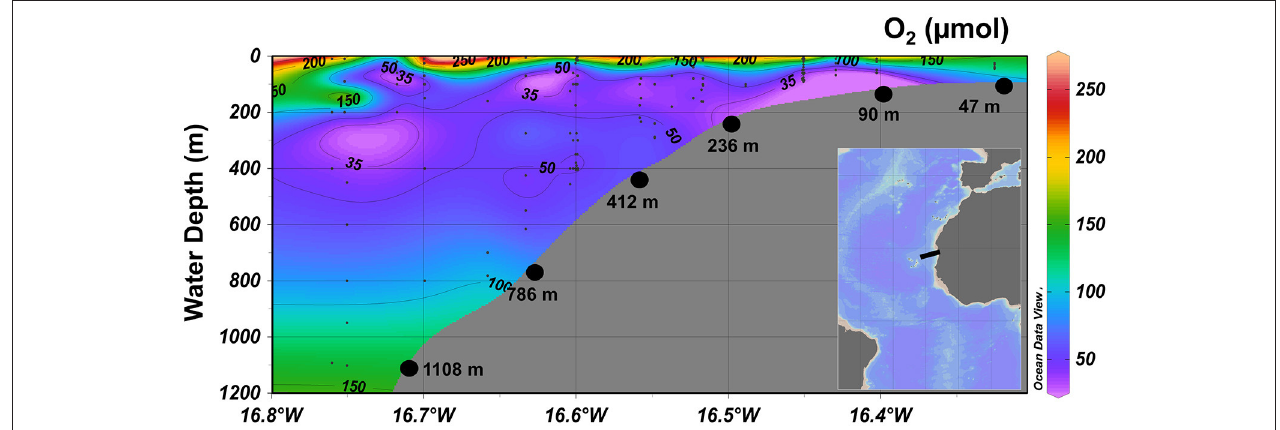
FIGURE 1 | Contour plot of dissolved O 2 ( µ M) concentrations along the continental margin of the Mauritanian OMZ at 18 ◦ N. The black dots represent stations for MUC sampling with corresponding water depth in meters. The inset shows the sampling area in a regional context (black box).